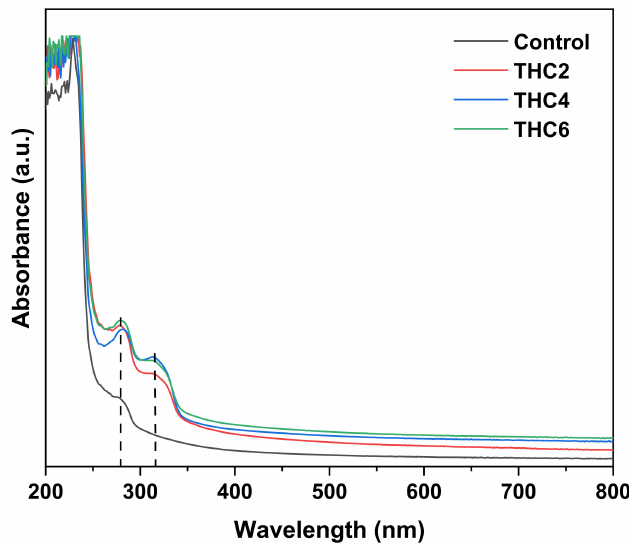
Figure 8. UV–Vis spectra of collagen